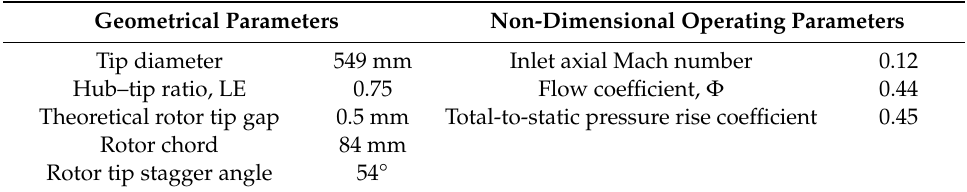
Table 1. Compressor parameters.